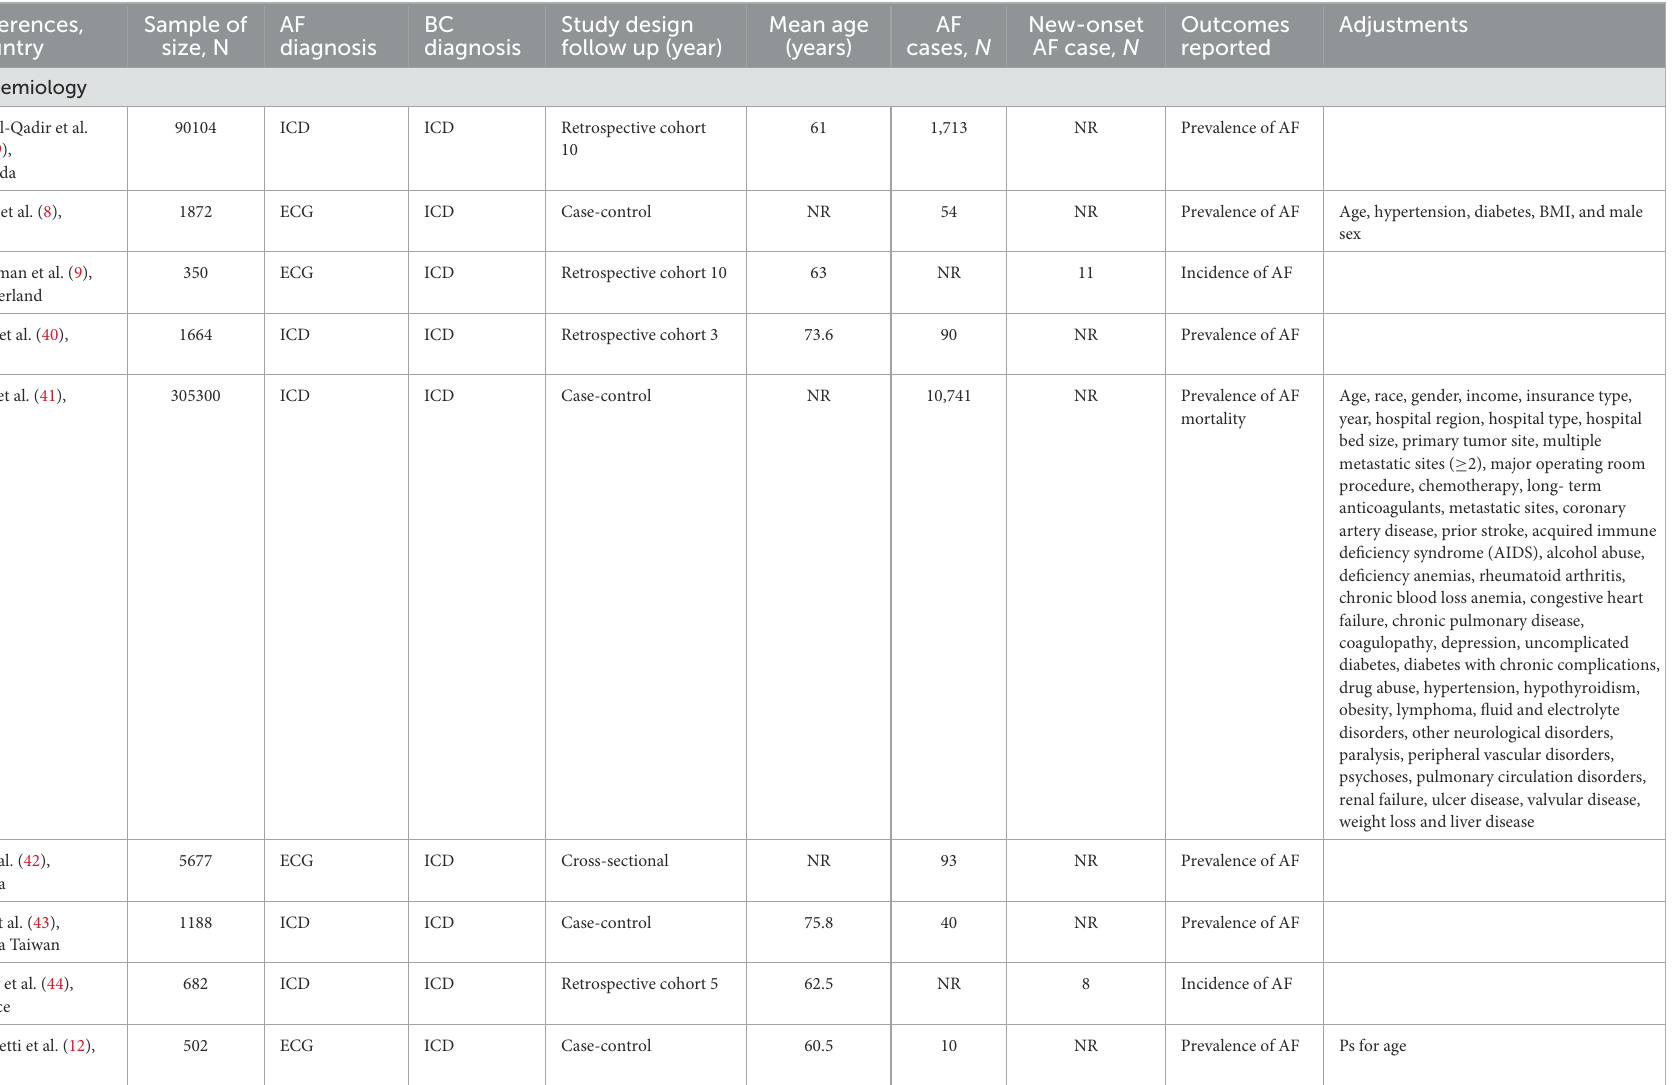
TABLE 1 Characteristics of included studies in this